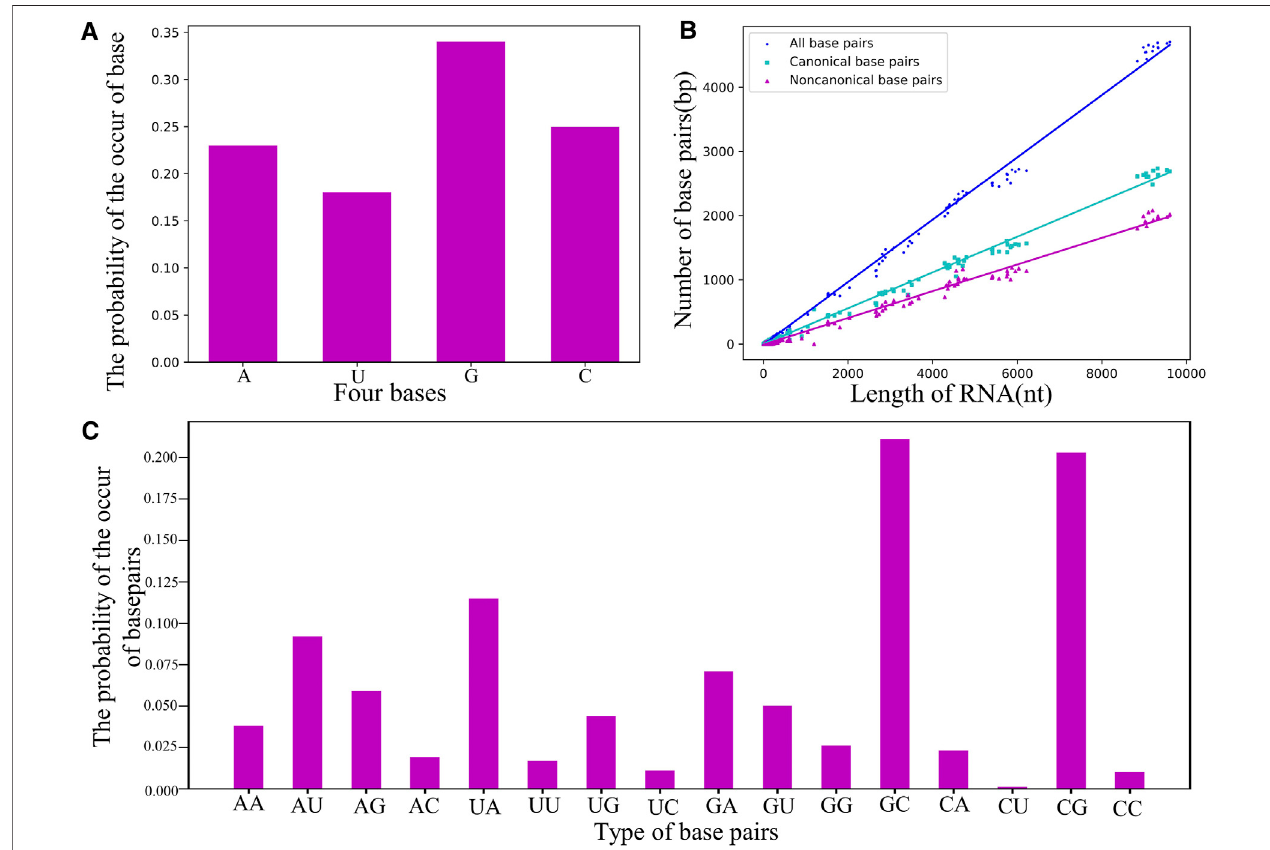
FIGURE 5 | (A) The probability of the occurrence of nucleotides in the non-redundant dataset. (B) The counts of base-pairs as a function of length N for RNA structuresinthedataset.Greensquares:canonicalbasepairs. Purpletriangle:non-canonicalbasepairs.Bluecircle:allcanonicalandnon-canonicalbasepairs. (C) The probability of the occurrence of base pairs including canonical and non-canonical